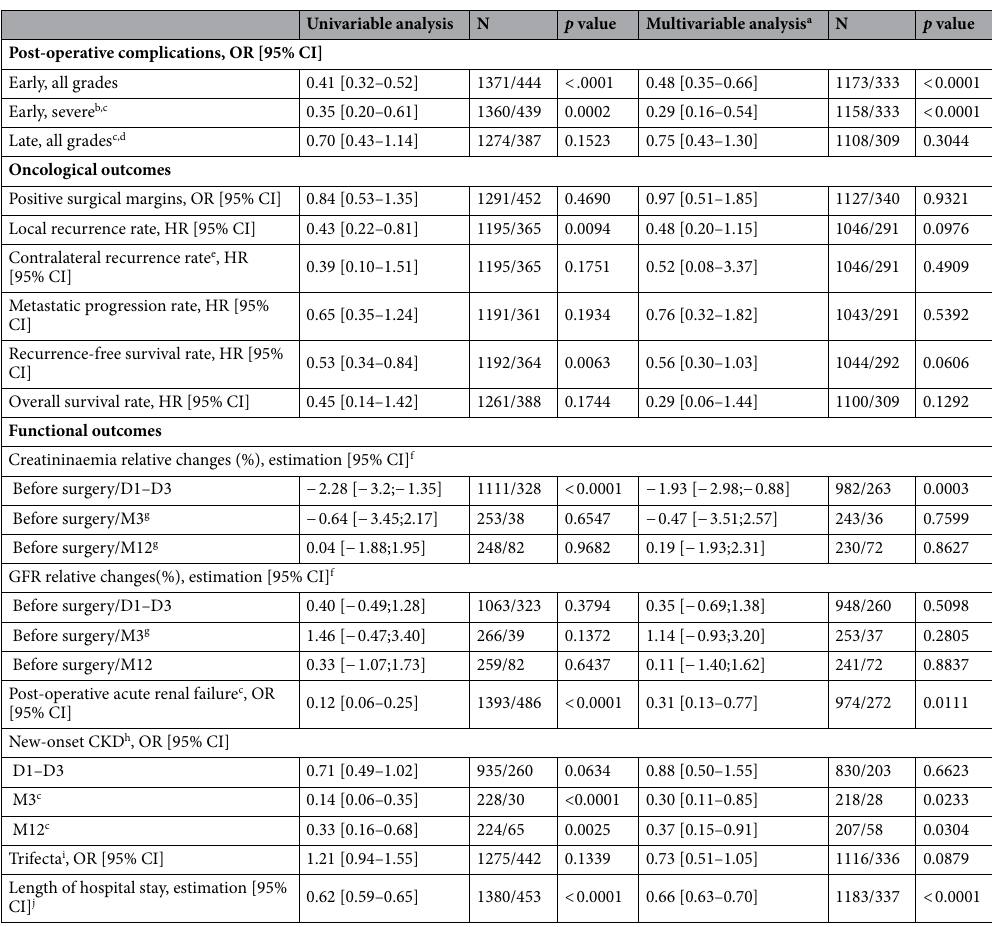
Table 2. Post-operative complications, oncological outcomes and functional outcomes in patients undergoing RPN versus OPN—univariable and multivariable analyses. N frequency (RPN/OPN), CI confidence interval, CKD chronic kidney disease, D day, GFR glomerular filtration rate, HR hazard ratio, M month, OR odds ratio. a Adjusted for the following prognostic factors: tumour size, imperative NSS indication, age at surgery, ASA score, BMI at diagnosis, and pre-operative creatininemia for post-operative acute renal failure and new- onset CKD only. b Surgical complications only. When the Clavien-Dindo grade 17 was not provided, data were considered to be missing. c As the mixed effects regression model failed to converge, the Firth’s penalization method was used. d Occurrence of at least one complication within 30 days post-surgery. e As the survival model failed to converge, the Firth’s penalization method was used. f To comply with model hypotheses, relative changes were calculated after transformation of the measured values into natural logarithms. g As the mixed effects regression model failed to converge, the random effect on the study centre was removed. h For patients with pre-operative stage I or II CKD only. i Trifecta was defined as negative surgical margins + zero peri-operative complications and a warm ischaemia time (WIT) ≤ 25 min. j To comply with model hypotheses, data for the length of hospital stay were transformed into natural logarithms. Estimations were the exponential of the model parameter, interpreted as a multiplicative factor: < 1 (> 1) means a shorter (longer) length of stay with RPN compared to OPN.